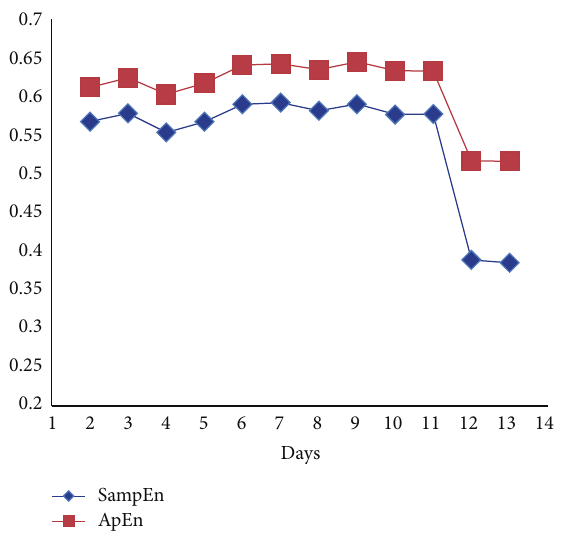
Figure 18: ApEn and SampEn value during the test for all days.